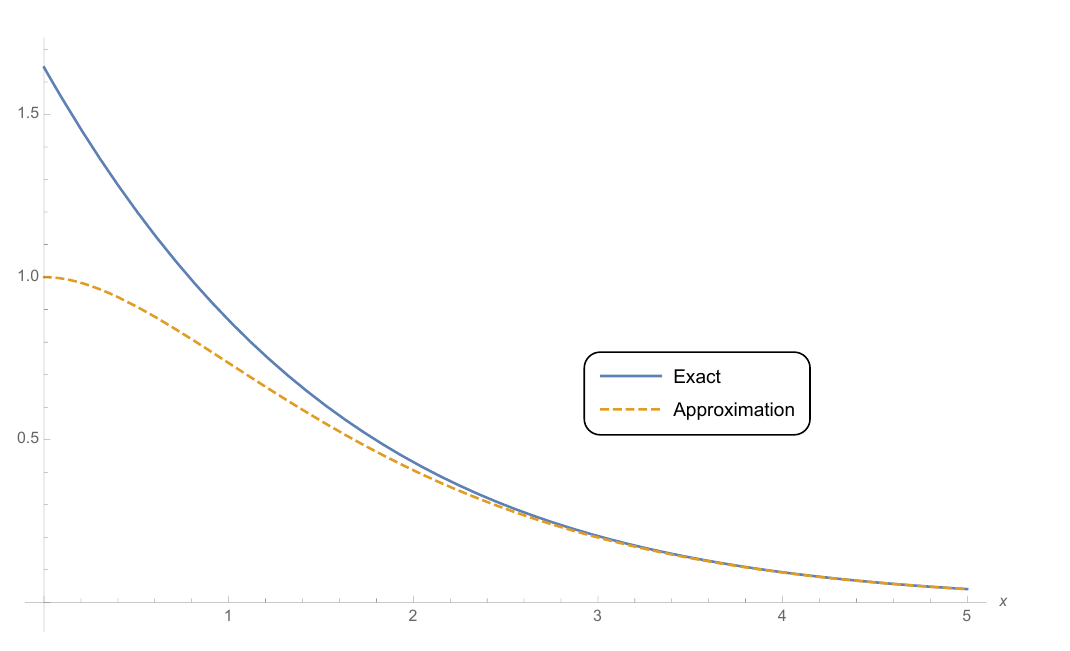
Figure 2 . The solid blue line labeled “Exact” is the left hand side of eq. (2.13) and the dotted yellow line labeled “Approximation” is the right hand side of eq.